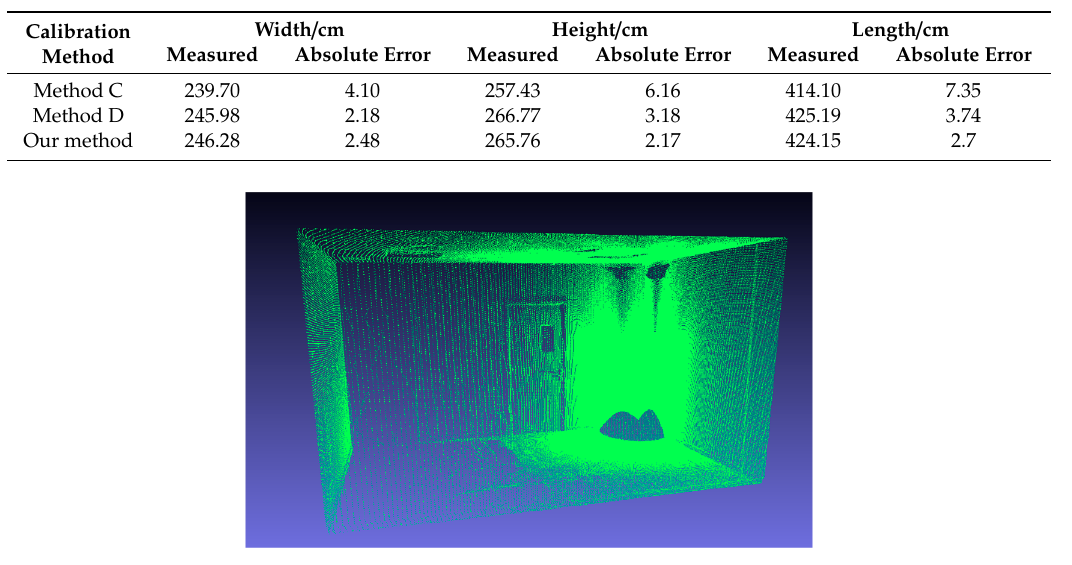
Figure 9. The model scanned by Faro .